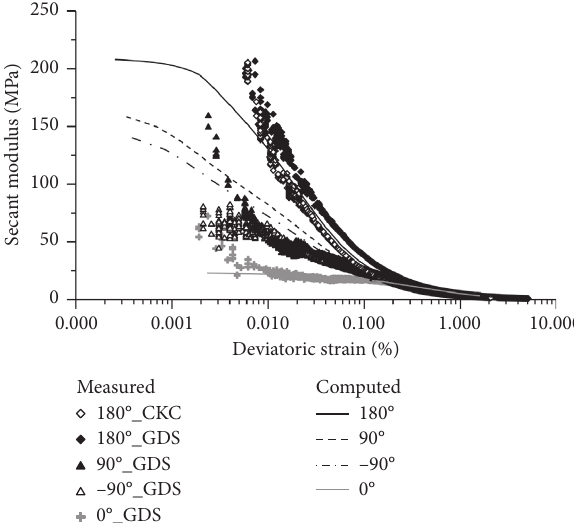
Figure 4: Measured and computed degradation curves of Toyoura sand subjected to varying recent stress histories